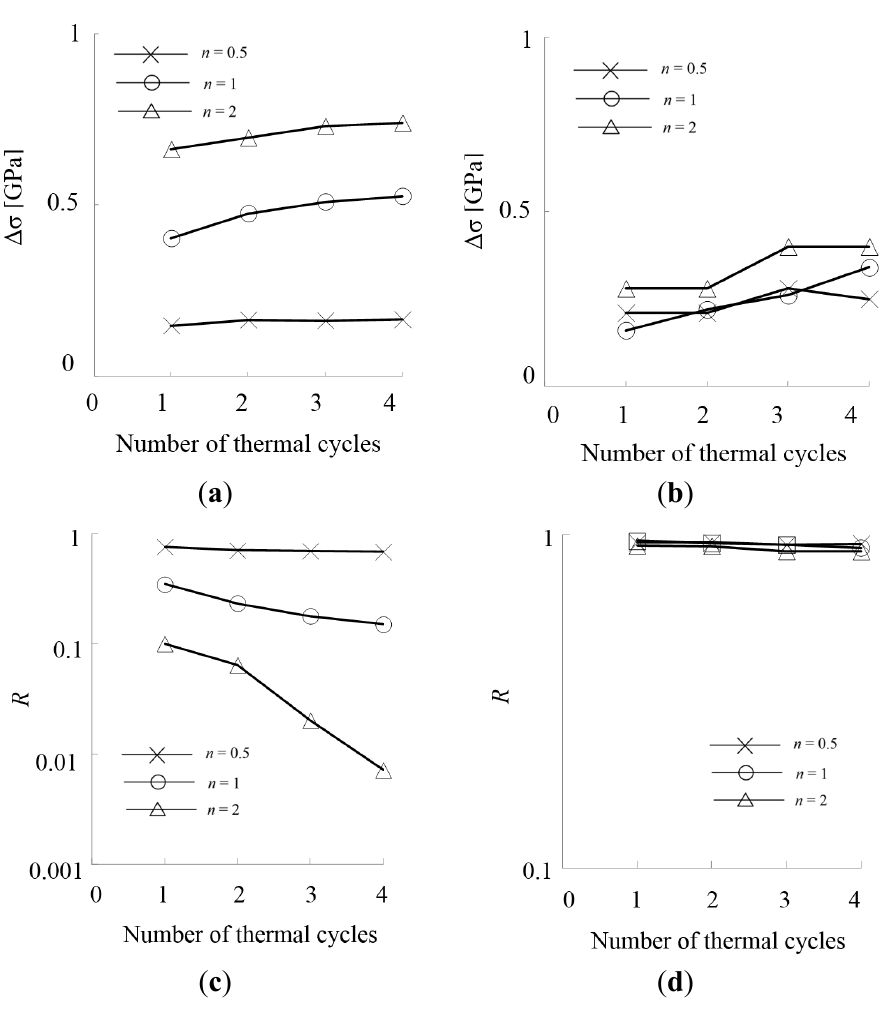
Figure 7. Amplitudes, Δσ , and ratios, R , of thermal stresses in ZrO 2 surface layer during = 0.01 μ m, ( b ) Δσ for d ZrO = 10 μ m, ( c ) R for thermal shock cycling. ( a ) Δσ for d ZrO 2 2 = 0.01 μ m, and ( d ) R for d ZrO = 10 μ m. d ZrO 2 2 Maximum equivalent thermal stresses, σ eq , in ZrO 2 surface layer during cyclic thermal shock loading max tests for d ZrO = 0.01 μ m and for d ZrO = 10 μ m are shown in Figure 8. It is seen that in case of high creep 2 2 than others, while in case of low rates of ZrO 2 ( d ZrO2 = 0.01 μ m), FG TBCs with n = 2 shows higher σ eq max = 10 μ m), FG TBCs with n = 0.5 shows higher σ eq than others. This tendency creep rates of ZrO 2 ( d ZrO max 2 is the same as that of σ max